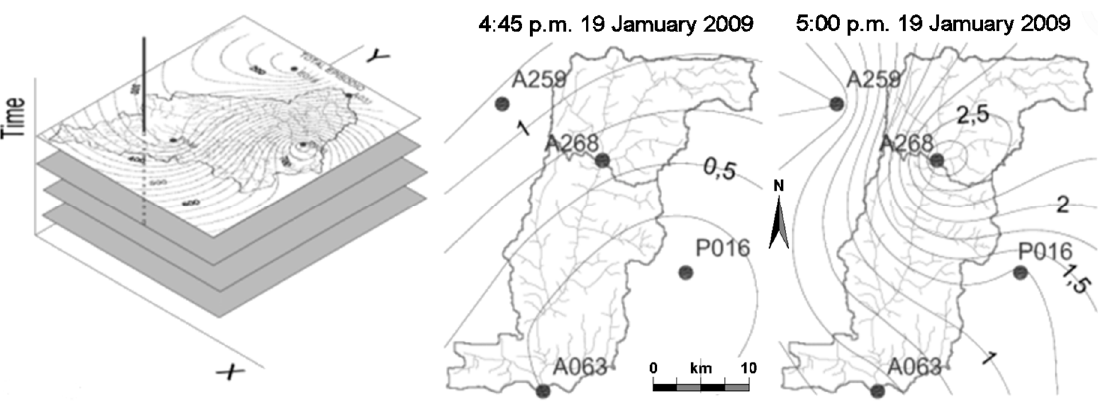
Figure 4. Isohyet maps of the event that occurred in January 2009 (equidistance 0.25 mm). A sequence of two coverage intervals of 15 minutes is presented. The whole event has 981 layers.